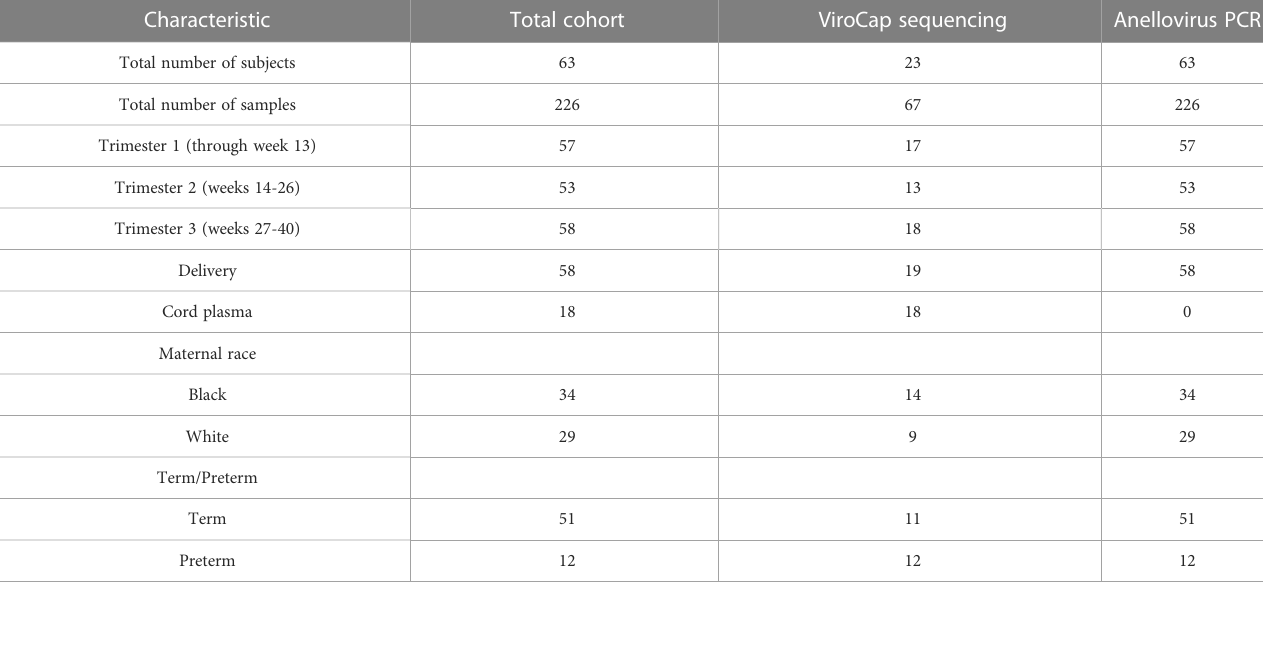
TABLE 1 Characteristics of cohort.